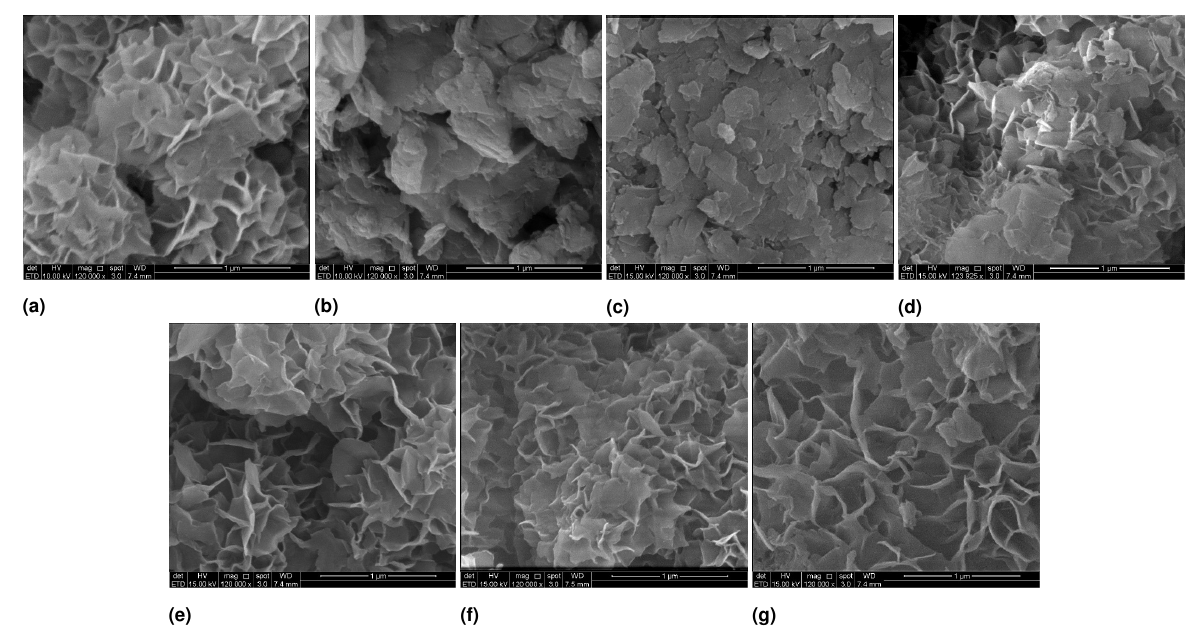
Fig. 5. SEM images of NiO nps (a) sample 1, (b) sample 2, (c) sample 3, (d) sample 4, (e) sample 5, (f) sample 6, (g) sample